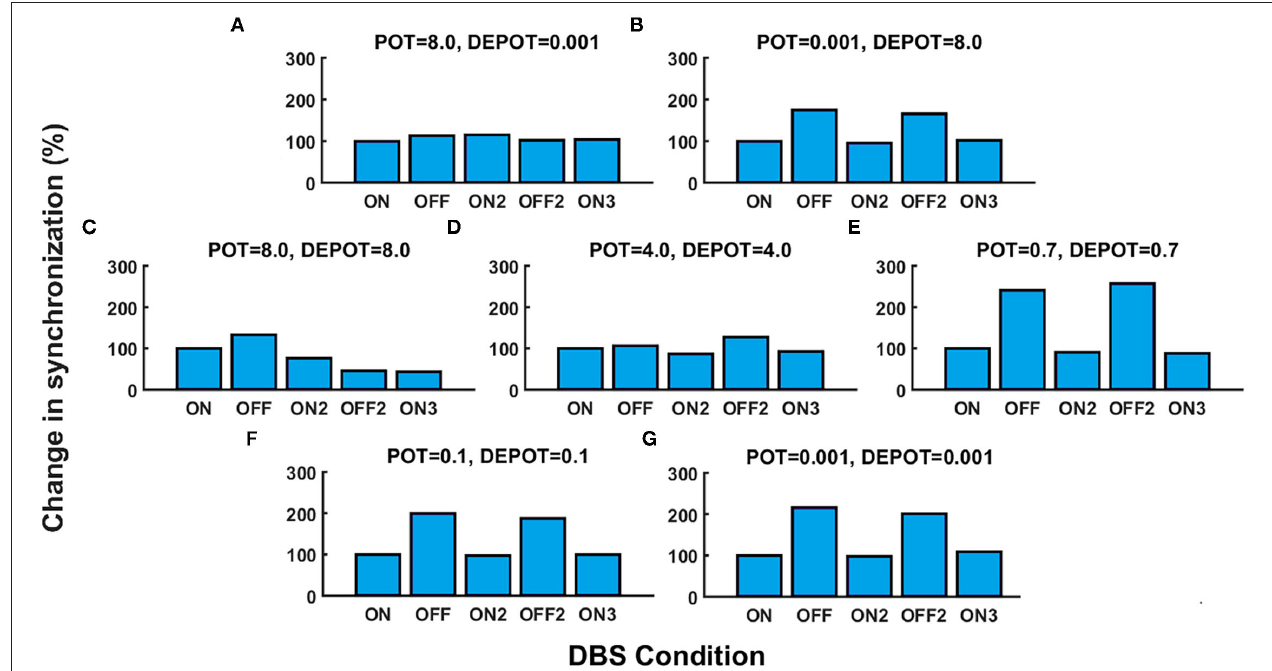
FIGURE 2 | The simulation results [percentage change of the grand average PLV, DBS ON represents the baseline level (100%)] corresponding to the long-term effect of DBS under successive withdrawal and renewal of stimulation: unbalanced potentiation and depotentiation (high and low level) (A,B) ; balance potentiation and depotentiation, i.e., equally high levels, (C) ; equally medium levels (D) ; equally low levels (E–G)